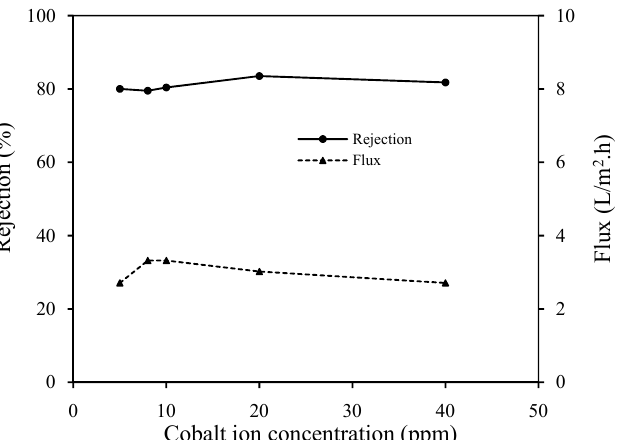
Fig. 8. Permeate flux and rejection percent of cobalt ions by the MMM containing 22 wt. % PES, 0.6 wt.% fMWCNTs versus feed flow rate (20 bar, 20 ppm Co(NO 3 ) 2 , pH=5.5±0.1, 90